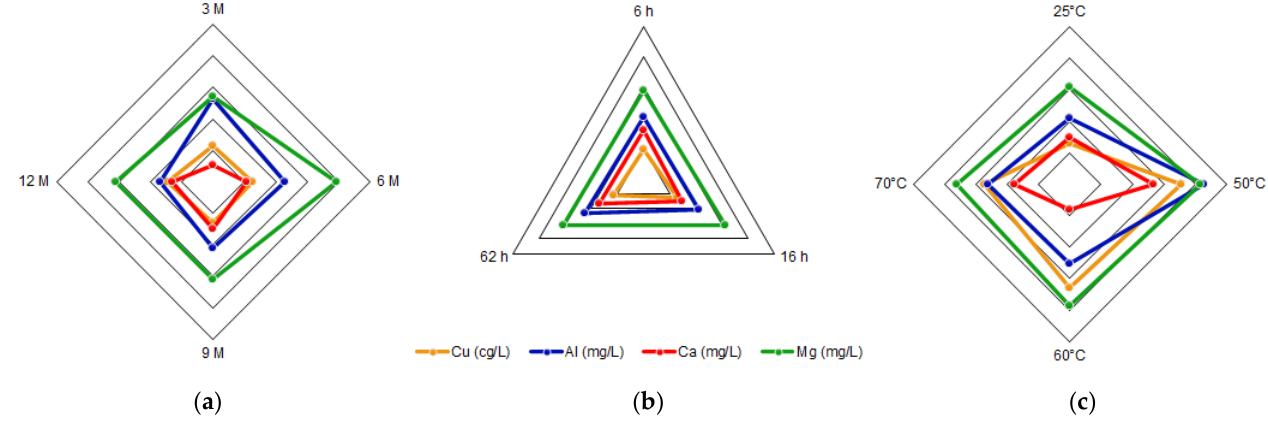
Figure 9. Radar chart of Cu, Al, Ca and Mg average concentrations as a function of ( a ) HCl concen- tration, ( b ) time and ( c ) temperature.